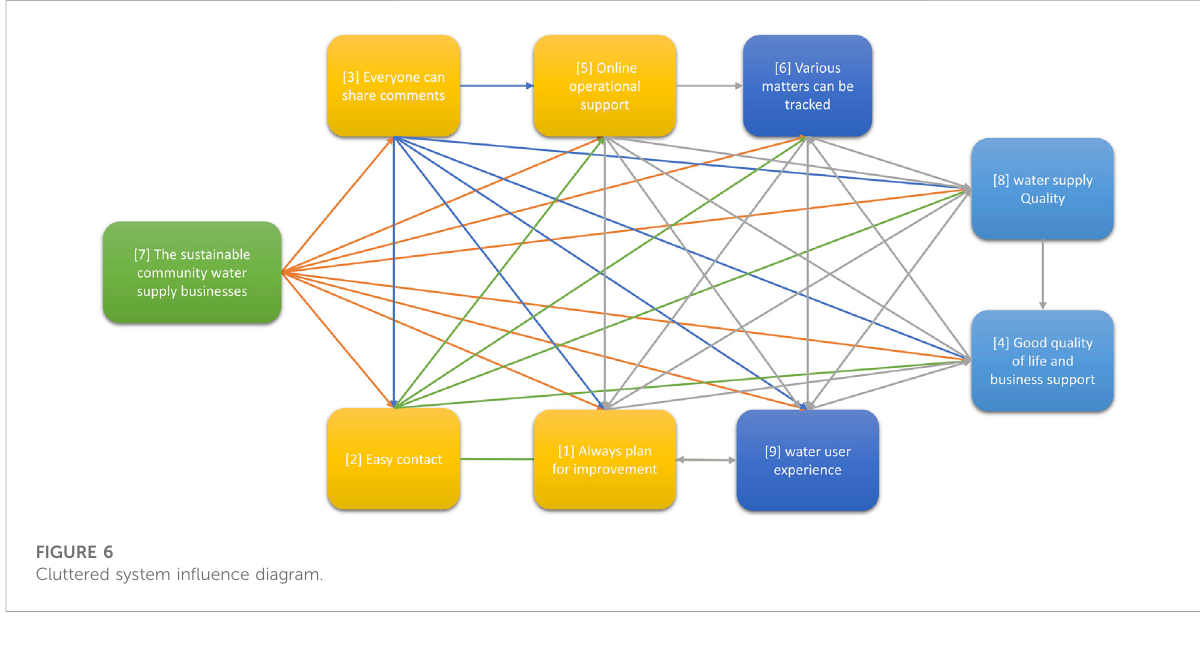
FIGURE 6 Cluttered system in fl uence